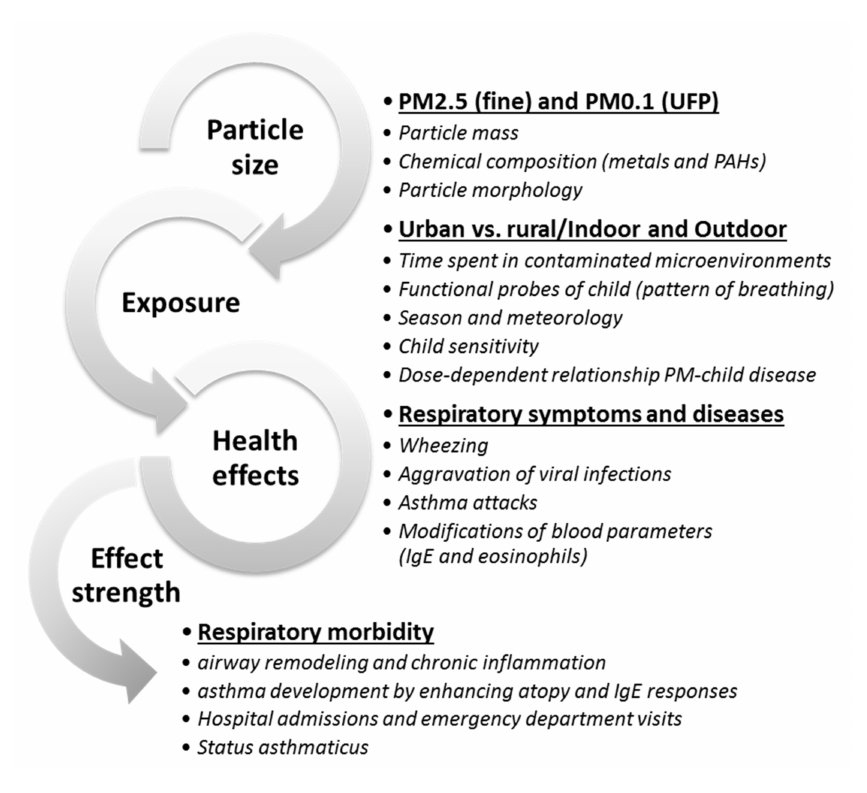
Figure 3. Synthetic representation of the main key points resulted from the literature